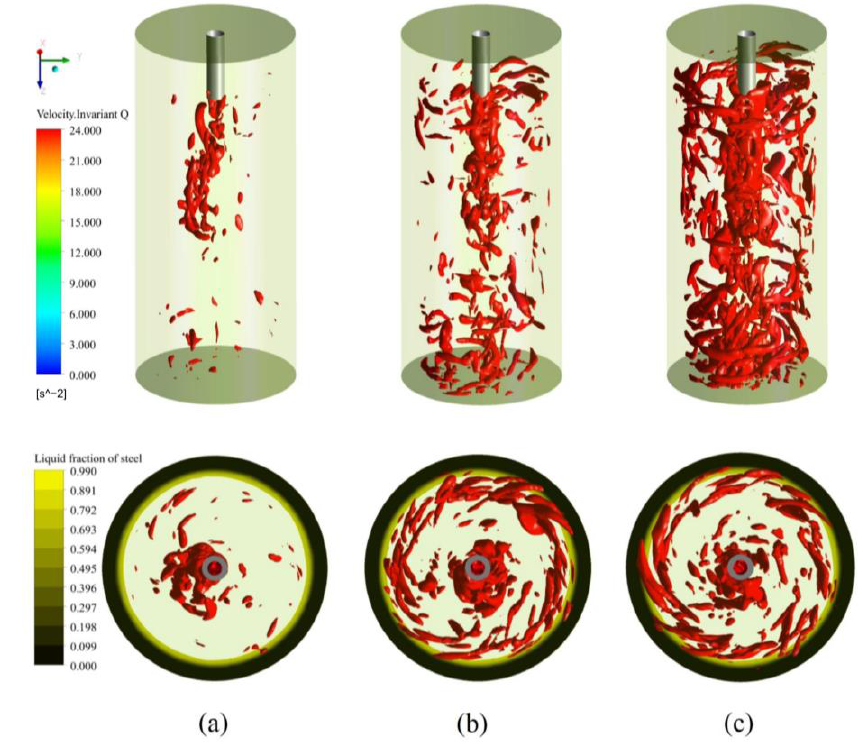
Figure 10. Velocity vectors and solidification shell growth at conditions of ( a ) 0.5 Hz, ( b ) 1.5 Hz, and ( c ) 2.5 Hz.